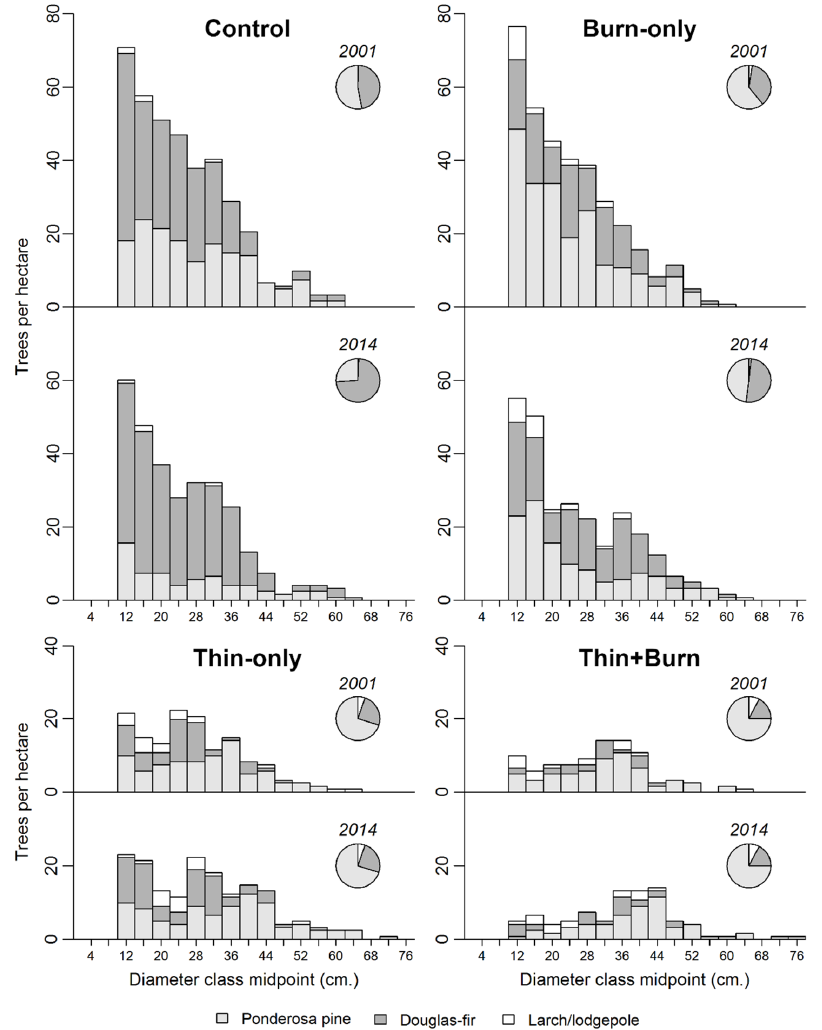
Figure 1. 2001 and 2014 diameter distributions by treatment, year, and species. Stacked bars show stem density by 4-cm classes (blocks pooled). Inset pie charts represent proportional basal area by species. Understory trees (less than 10 cm dbh) are not shown.